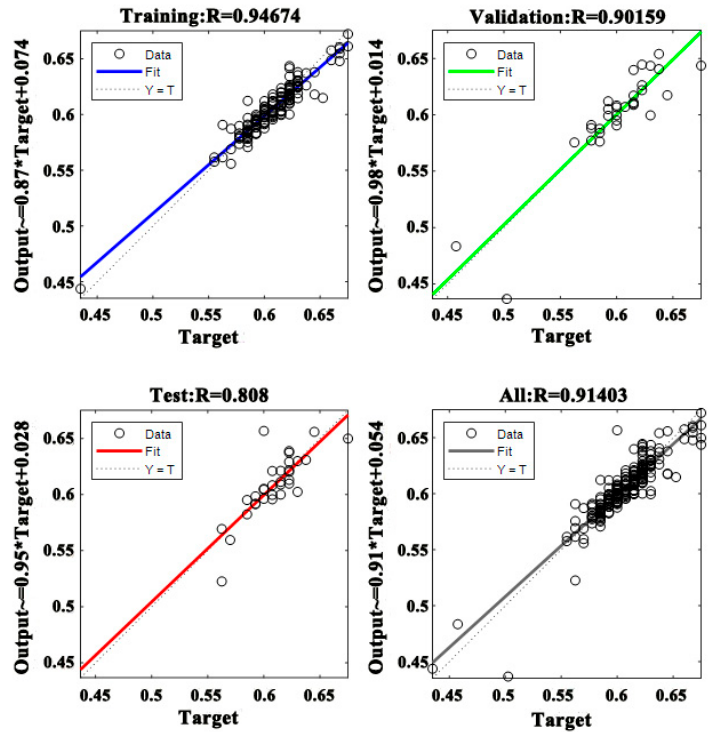
Figure 4. Schematic diagram of BP Neural network training fit degree.